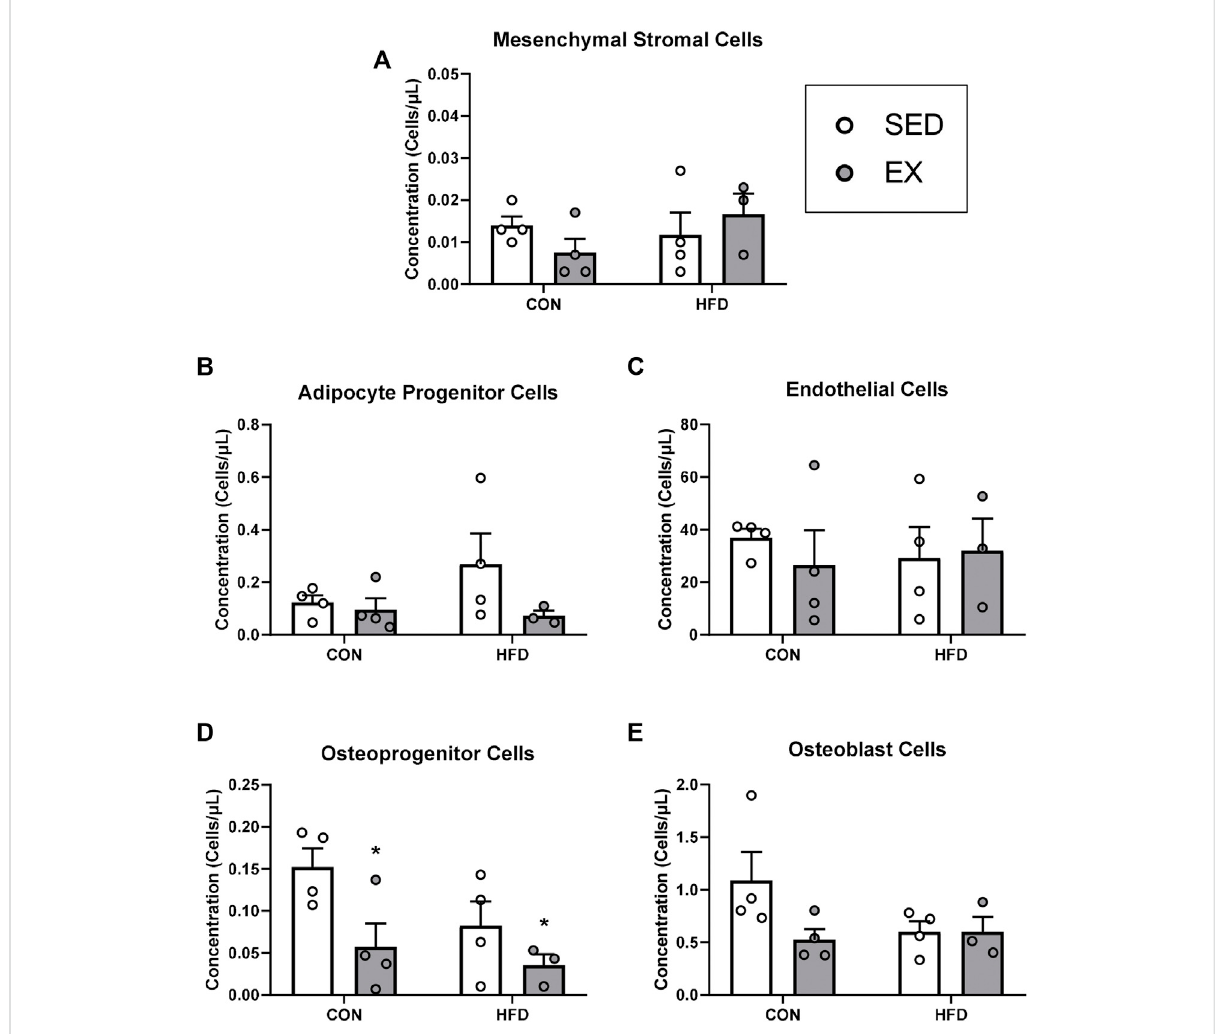
FIGURE 4 Extracellular vesicles from exercise-trained mice decrease osteoprogenitor cell concentrations. (A) Mesenchymal stromal cells, (B) adipocyte progenitor cells, (C) endothelial cells, (D) osteoprogenitor cells, and (E) osteoblast cells. * p < 0.05 main effect of exercise ( n = 4 per group, HFD-EX n =